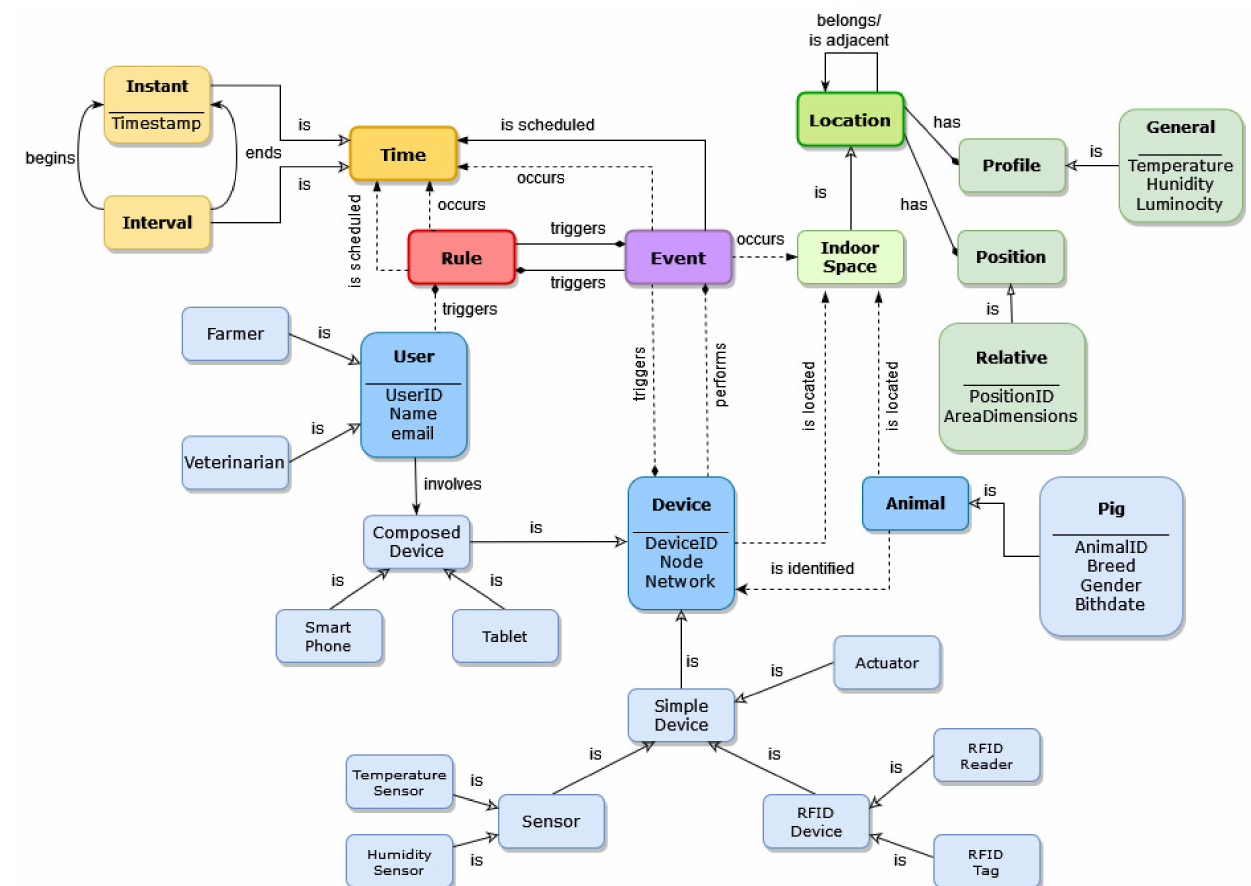
Figure 12. Instance of indicative modeling structure for smart control of the thermal environment in a pig farming